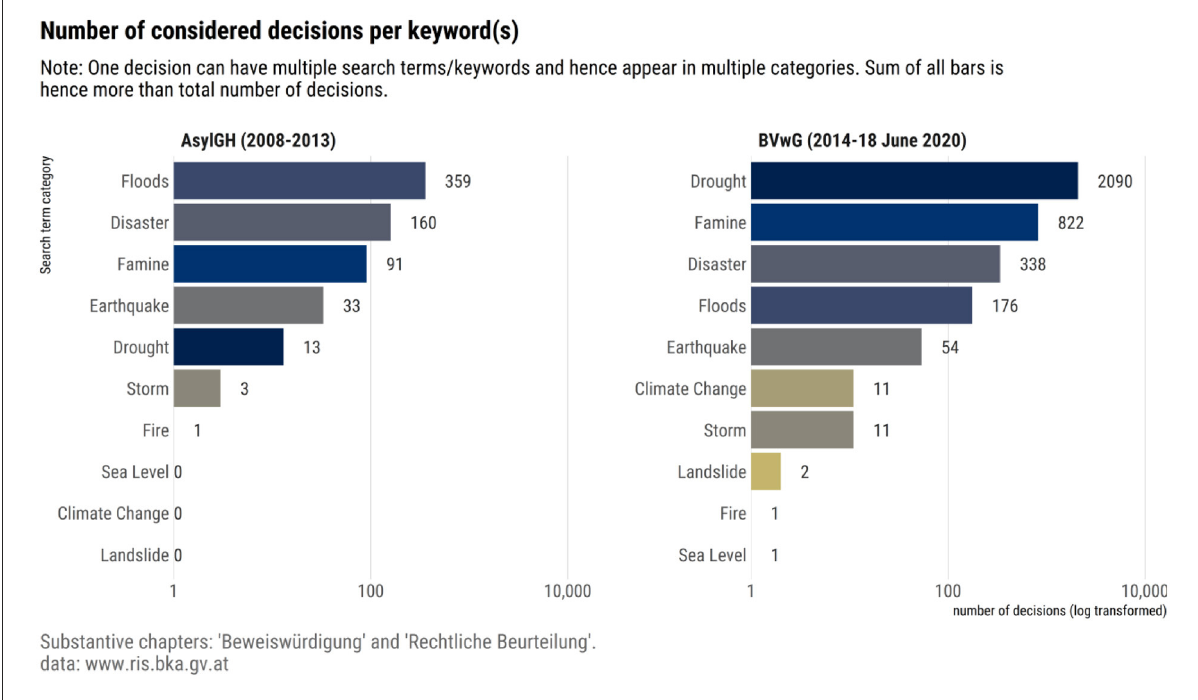
FIGURE2 Keywords mentioned in decisions before the AsylGH and